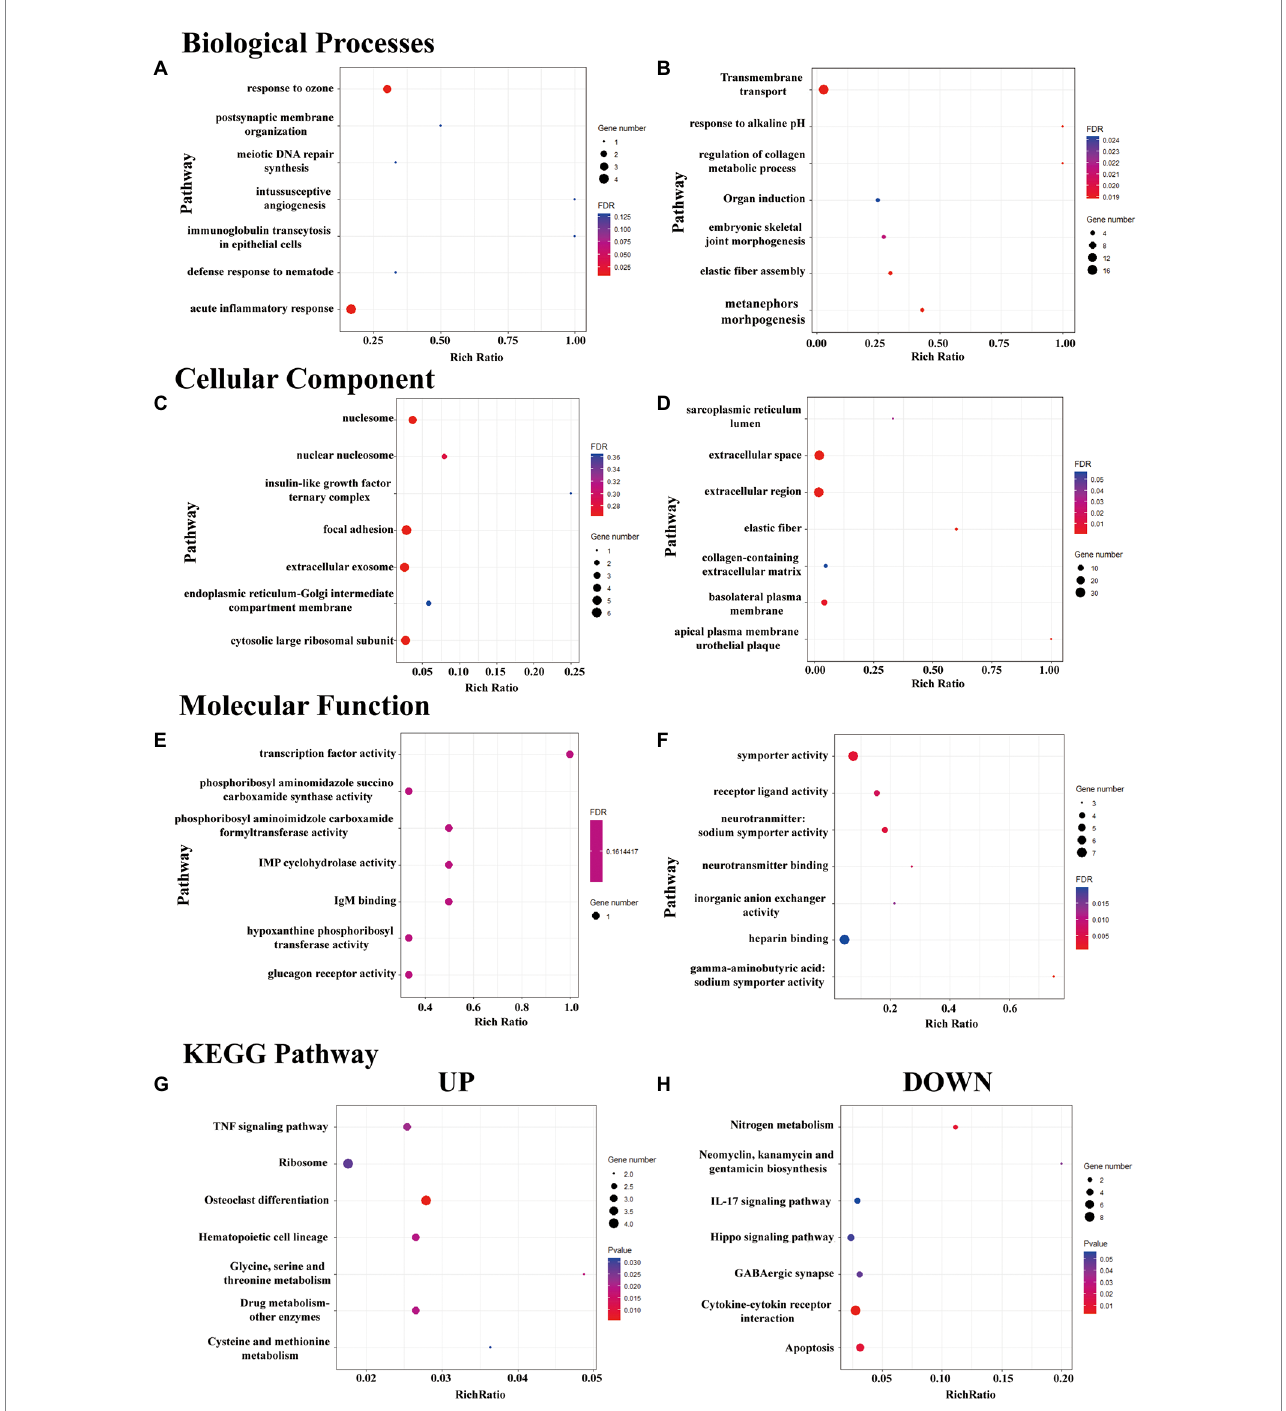
FIGURE 3 GO enrichment and KEGG pathway analysis of DeRNAs. (A–F) The top seven mostly significantly enriched BP, CC, and MF terms for the up- and downregulated DeRNAs. (G,H) The top seven mostly significantly enriched pathways for the up- and downregulated